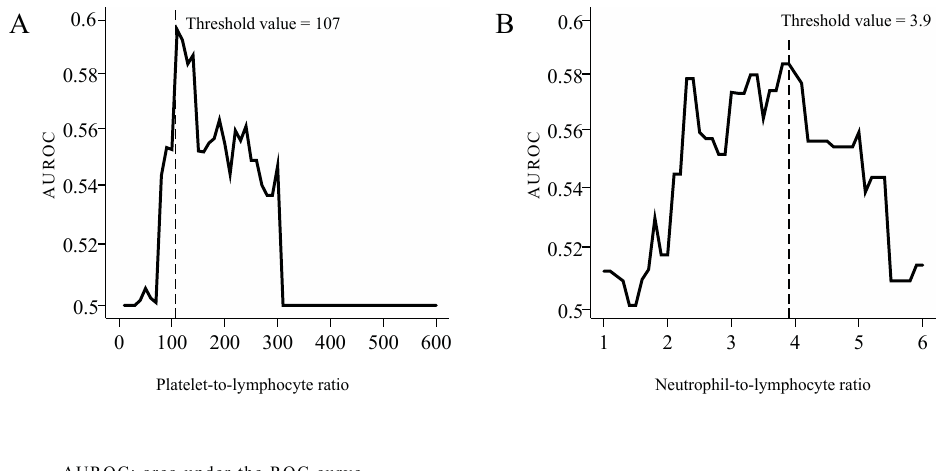
Figure 1. Threshold values of PLR (A) and NLR (B) .